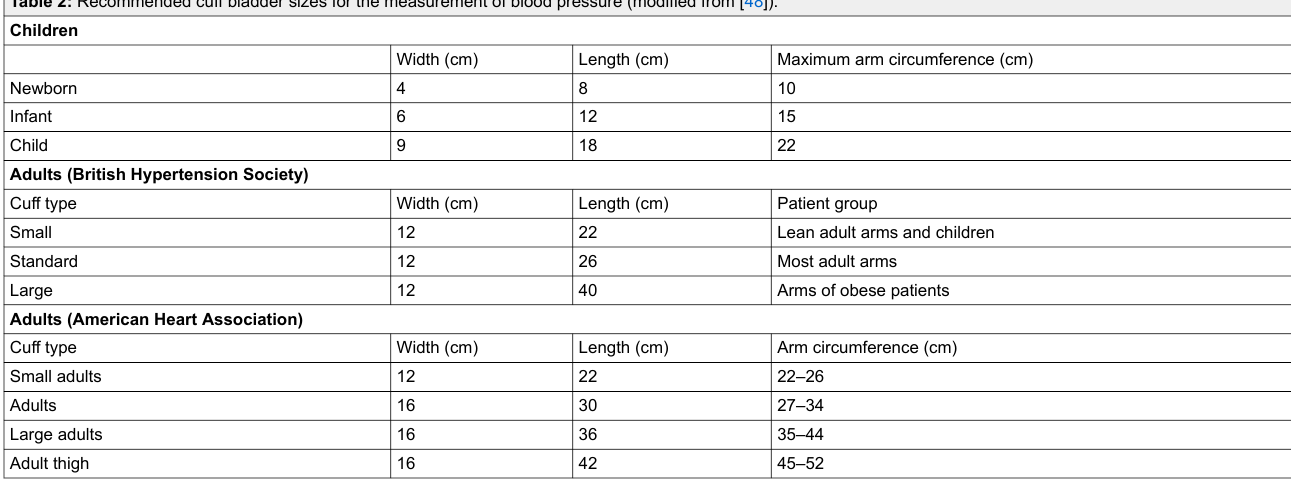
Table 2: Recommended cuff bladder sizes for the measurement of blood pressure (modified from